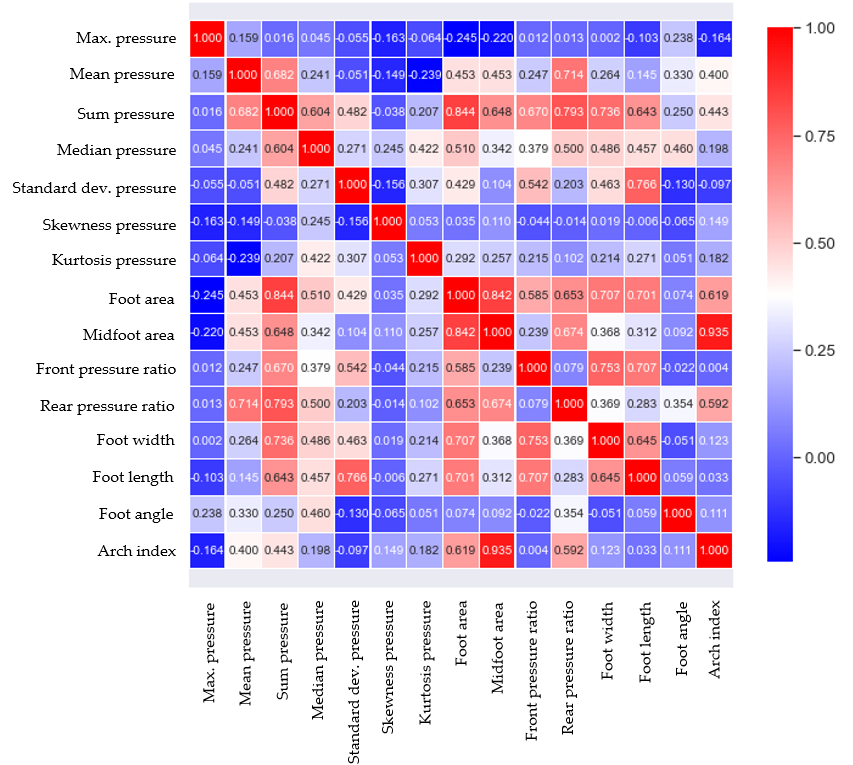
Figure 9. Correlation analysis results for features and arch index. Table 2. Selected features.